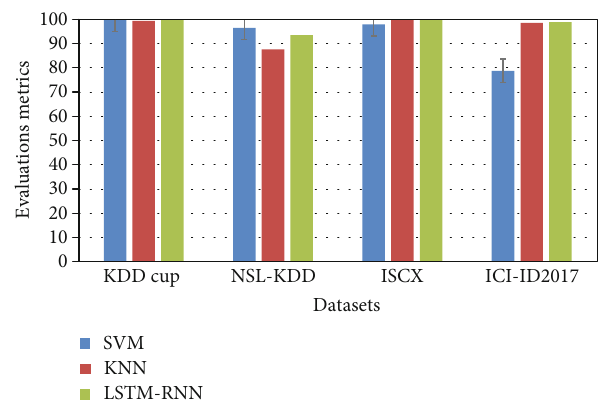
Figure 9: Comparison of the LSTM-RNN against machine learning algorithms in terms of accuracy